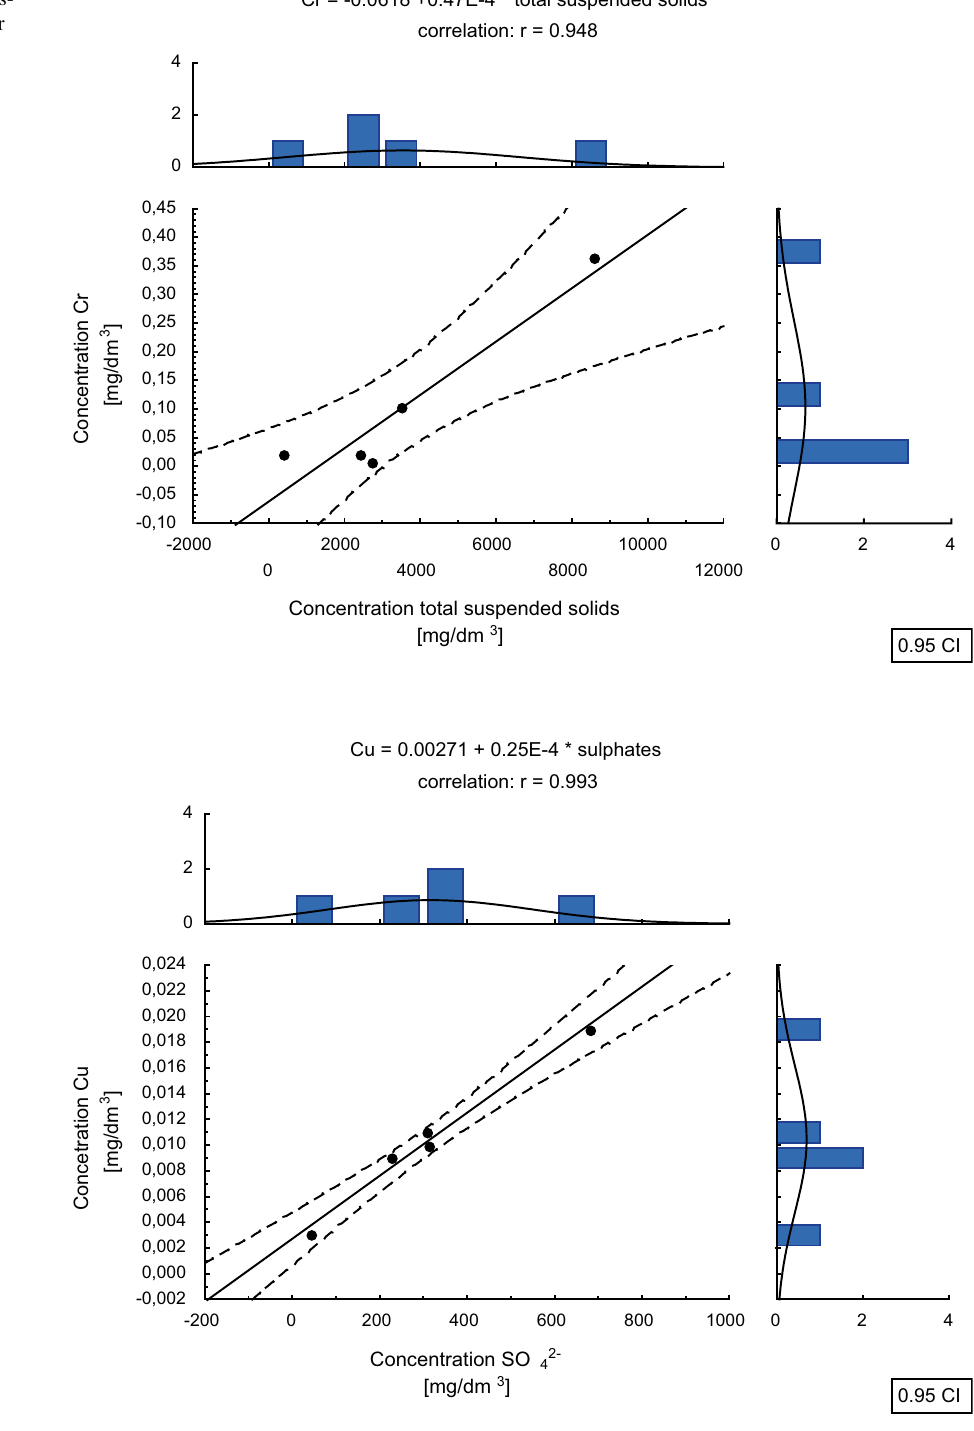
Cr = -0.0618 +0.47E-4 * total suspended solids correlation: r = 0.948